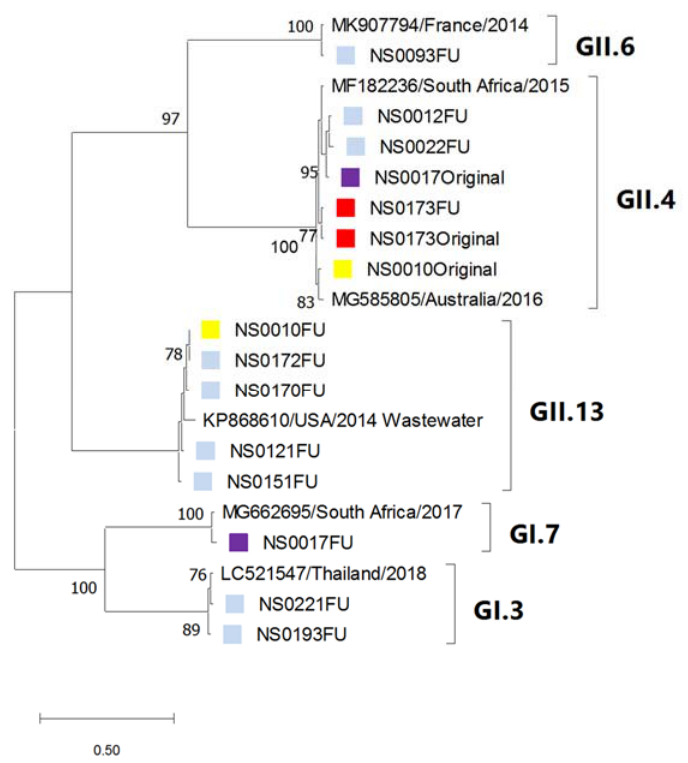
Figure 5. Comparison of norovirus strains detected in symptomatic and asymptomatic children. Maximum likelihood phylogenetic tree of the partial capsid gene (GI—288 bp; GII—276 bp) of the norovirus strains detected in children six weeks after initial hospitalisation with gastroenteritis at KPTH between July 2016 and December 2017 (blue blocks). The norovirus strains that were detected in two children at initial hospitalisation and at 6-week follow up are shown in matched colours (NS0017—yellow; NS0173—red). Closely related strains from GenBank are indicated by accession numbers. Bootstrap support of >70% is shown. The scale bar represents 0.5 nucleotide substitutions per site over the indicated region.